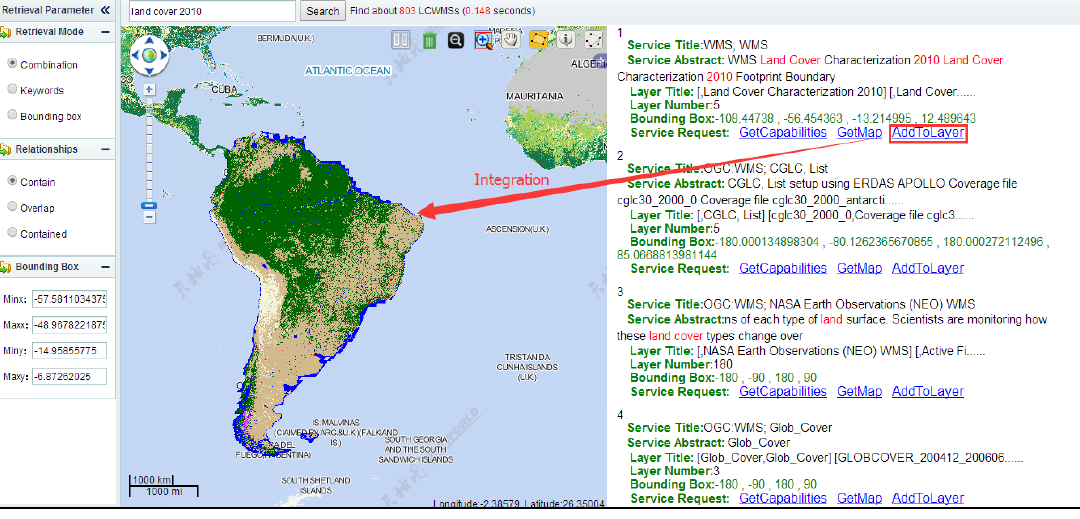
Figure 11. Interface displaying the integration of land cover web map services.